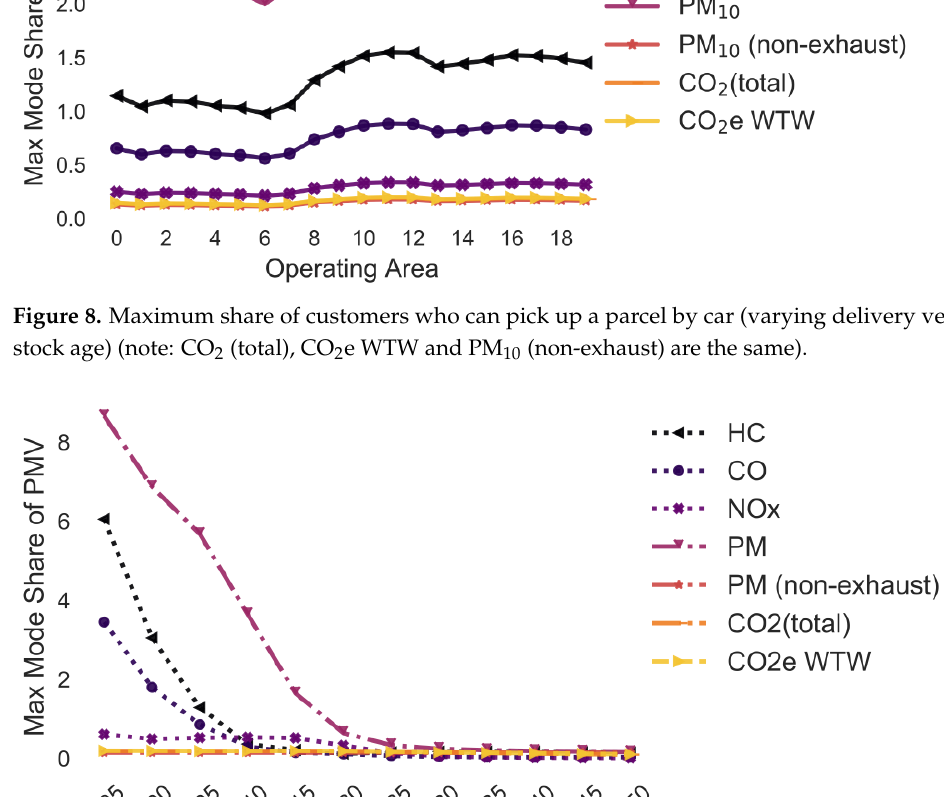
Figure 9. Maximum share of customers who can pick up a parcel by car (average over operating areas, varying delivery vehicle age) (note: PM 10 (non-exhaust), CO 2 (total) and CO 2 e WTW are the same).